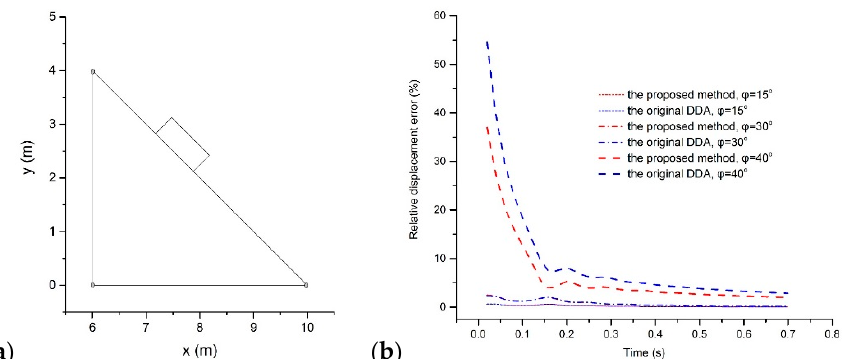
Figure 7. ( a ) The configuration of the sliding problem and ( b ) the relative displacement errors of the proposed method and DDA with the post-adjustment strategy.